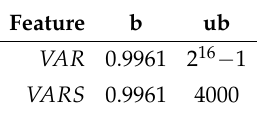
Table 7. Parameters of VAR